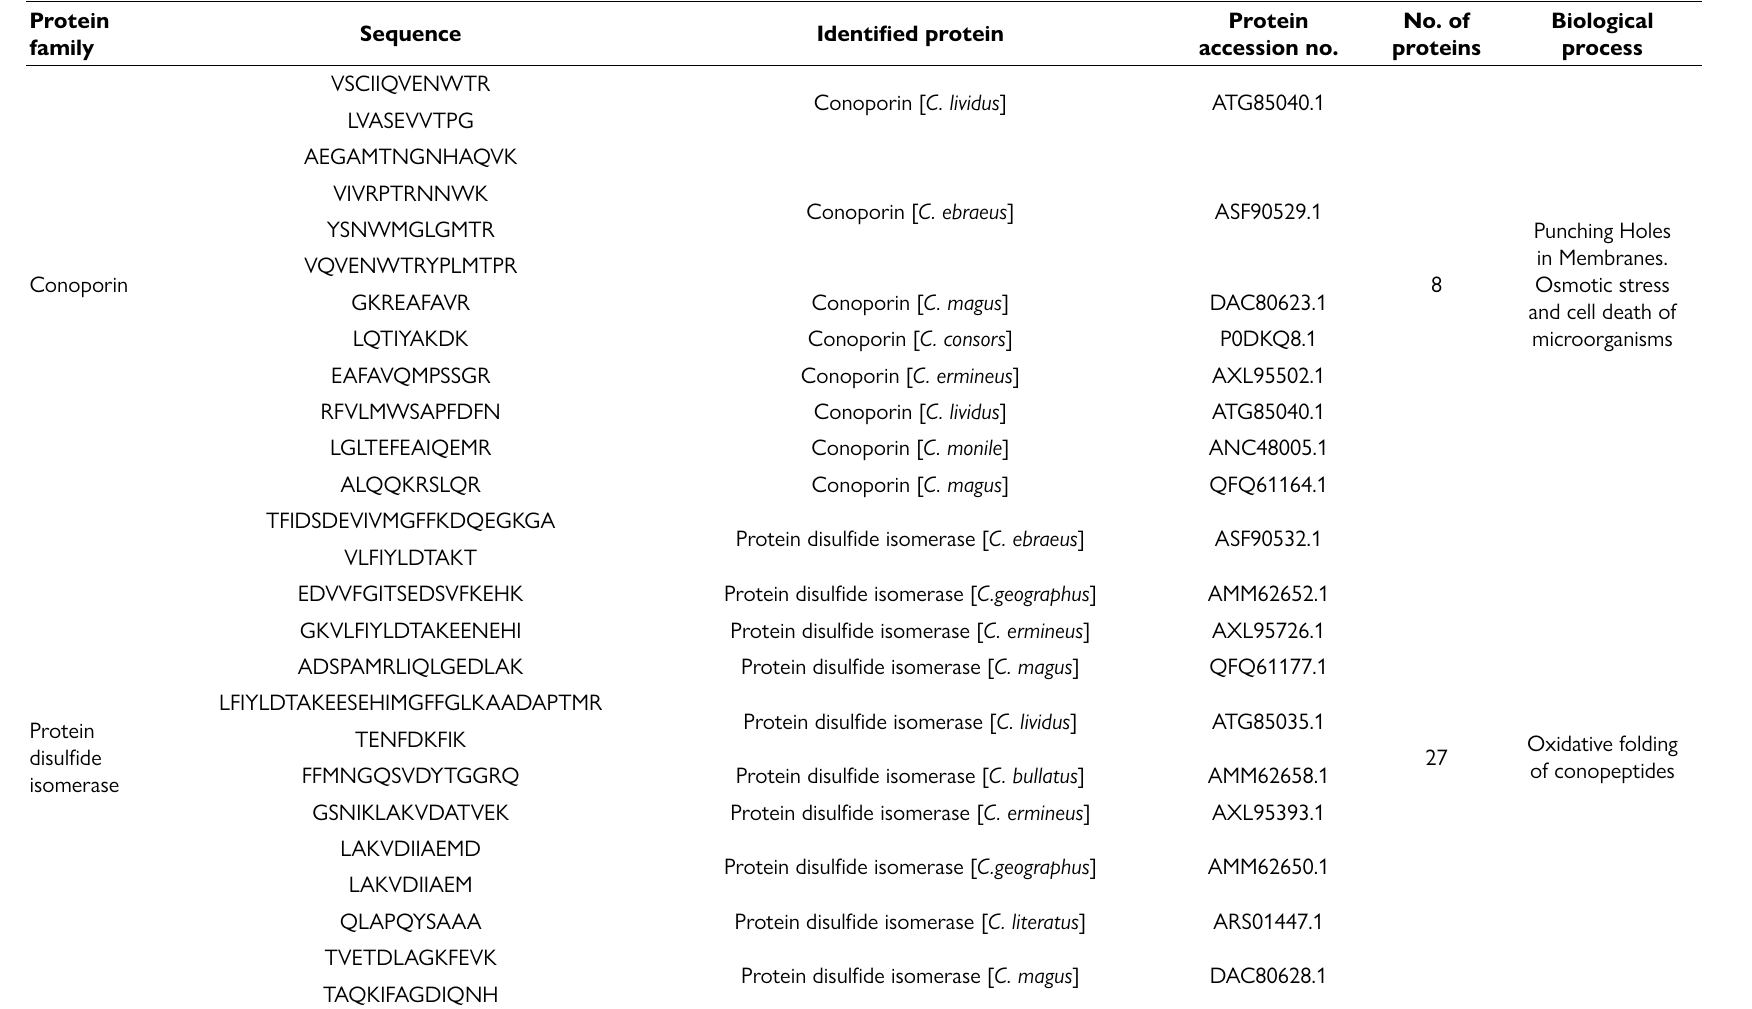
Table 2. List of non-conotoxin proteins identified in Egyptian C. taeniatus venom by using MALDI/TOF/MS. Protein Sequence Identified protein family